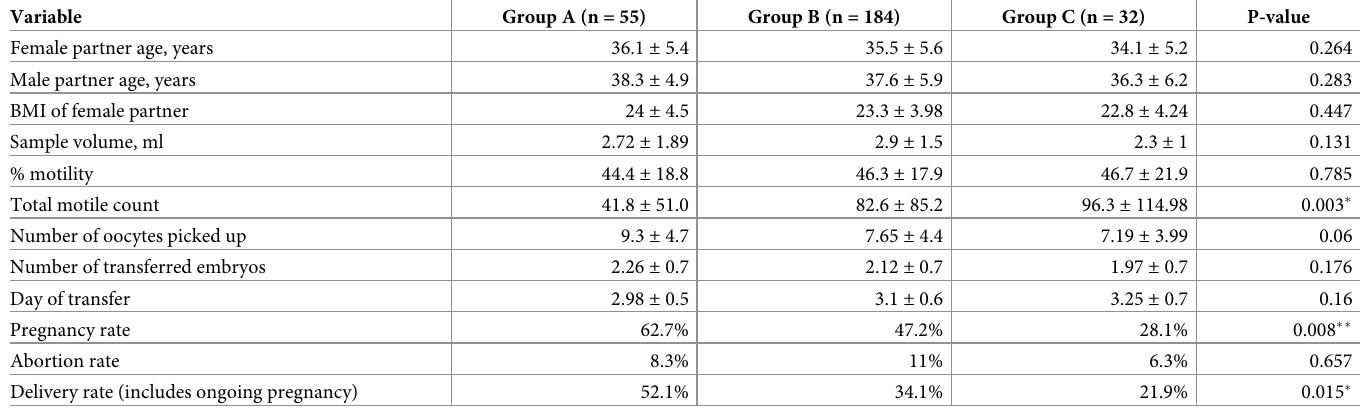
Table 3. Demographic and clinical characteristics of the three